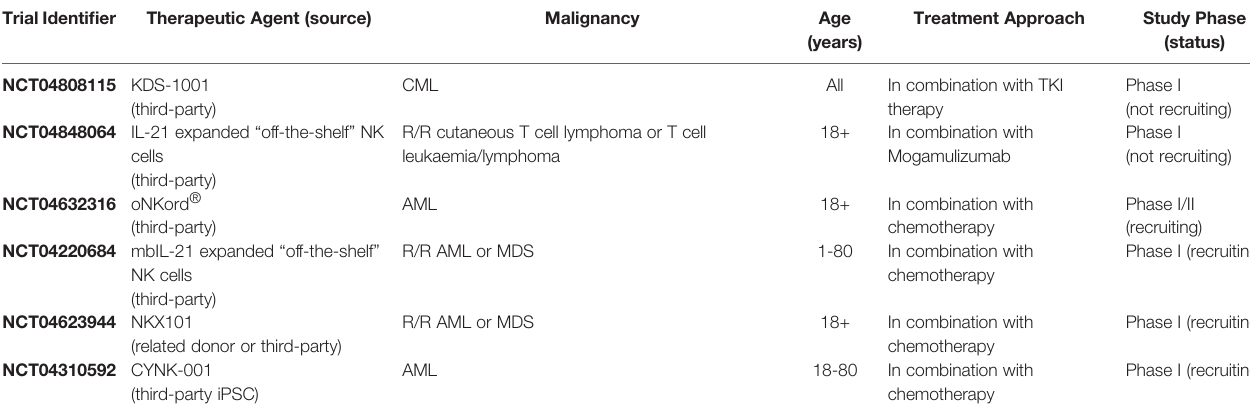
TABLE 1 | Clinical trials of “ off-the-shelf ” adoptive NK cell therapies for the treatment of hematological malignancies. Trial Identi fi